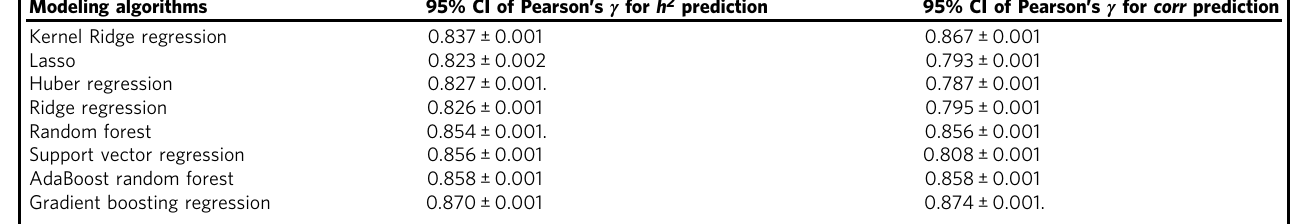
Table 1 Performance comparison of different modeling algorithms.